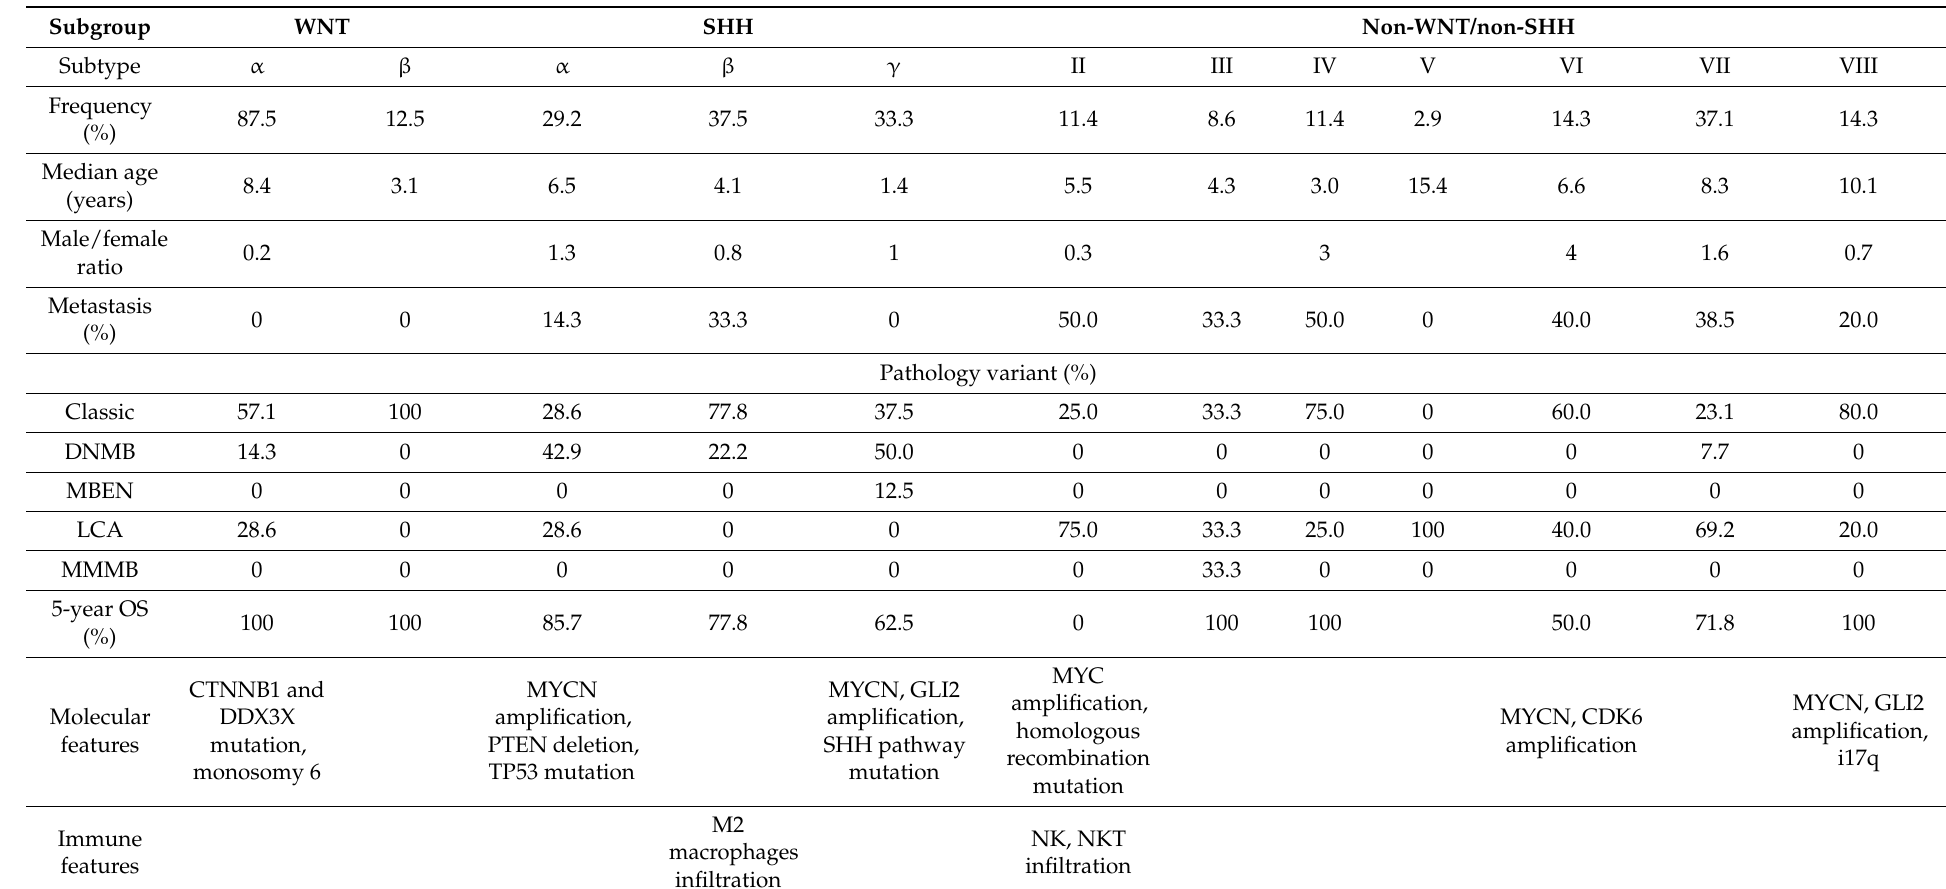
Table 1. The demographic, clinical annotations, molecular and immune features of MB subtypes in our